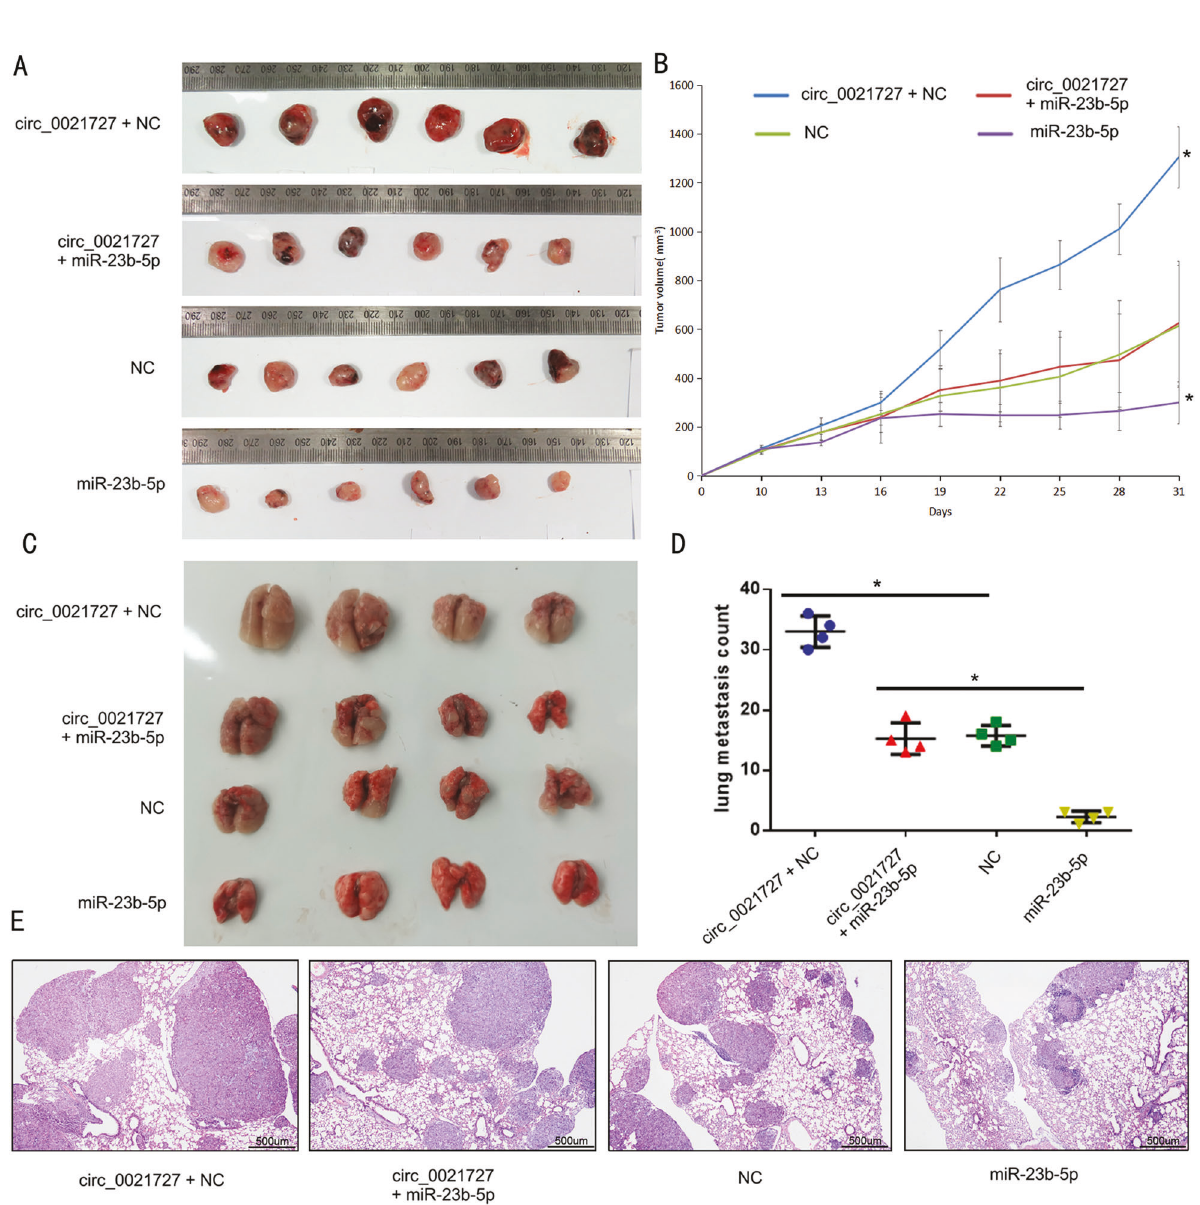
Fig. 6 Hsa_circ_0021727 promotes the metastasis and proliferation of ESCC cells in vivo by regulating the expression of miR-23b-5p. A Image showing the subcutaneous xenograft tumor tissues injected with KYSE510 cells co-transfected with miR-23b-5p and hsa_circ_0021727 overexpression vectors. B Graphs of tumor volumes in subcutaneous xenograft tumor models. C Image of lung metastatic nodules. Nude mice were injected with KYSE510 cells co-transfected with miR-23b-5p and hsa_circ_0021727 overexpression vectors. D Statistical analysis of lung metastatic nodules. E Lung tissue was stained using HE. Values are expressed as the means ± SD; * P < 0.05. dataset, there was no statistical difference( p = 0.239 ) between the eight specimens from patients with ESCC for qRT-PCR and western expression of TAB1 and the survival time of ESCC patients(Fig. blotting analysis. The results revealed that hsa_circ_0021727 S2C). N-(4-Ethylphenyl)-N ′ -phenylurea (INH14) reduced NF-kB expression correlated negatively with the expression of miR-23b- activation by inhibiting IKK [34], thus we could block the NF κ B 5p, but positively with the expression of TAB1 (Fig. 7J – L). In TCGA Cell Death and Disease (2023)